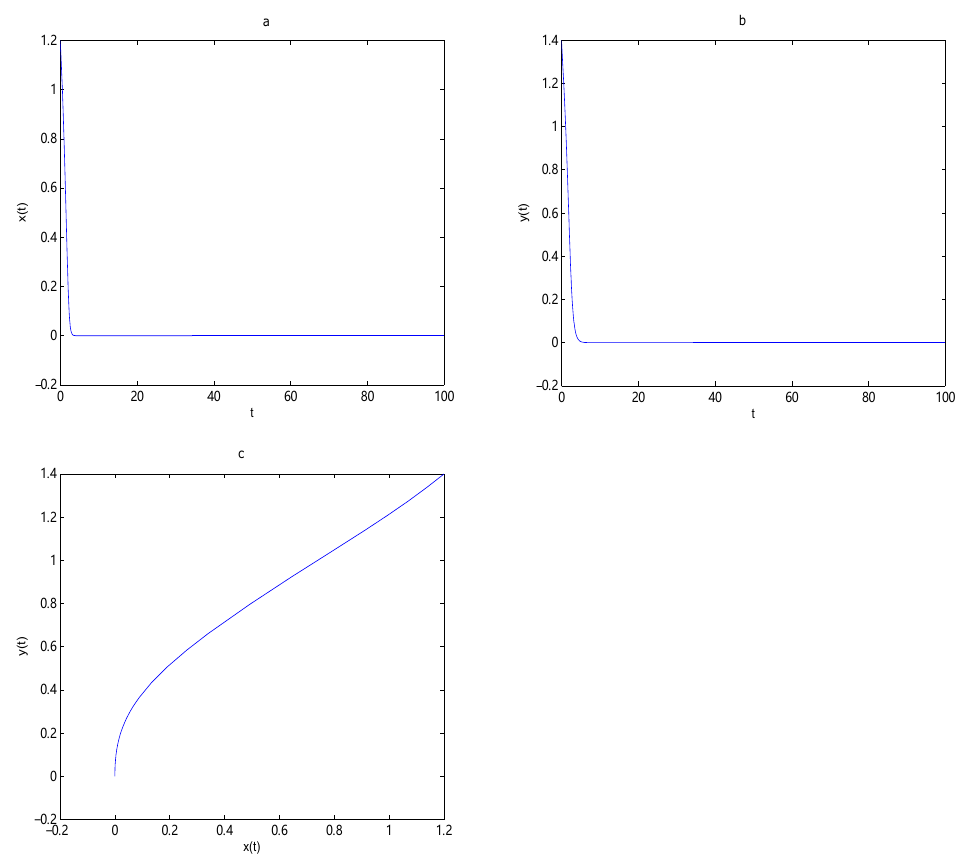
Figure 10. O is locally stable. A 2 (1.75, 1.75) is a saddle. A 3 (2.581, 2.581) is locally stable. The trajectory tends to O when the initial value is ( x ( 0 ) , y ( 0 )) = ( 1.2,1.4 ) . In here r = 2, ω = 0.414, b = 0.5, c = 2.87, α = 1.674. Subfigure ( a ) is time series of x ( t ) , subfigure ( b ) is time series of y ( t ) , and subfigure ( c ) is phase diagram of system